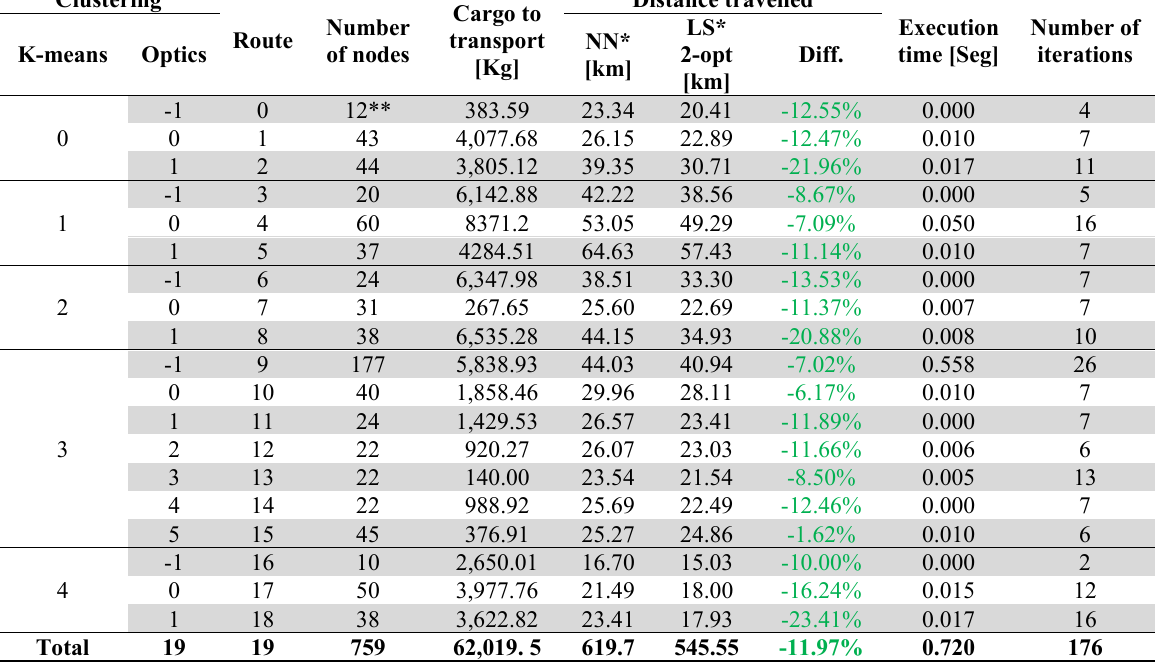
Results per route for 758 nodes (customers)